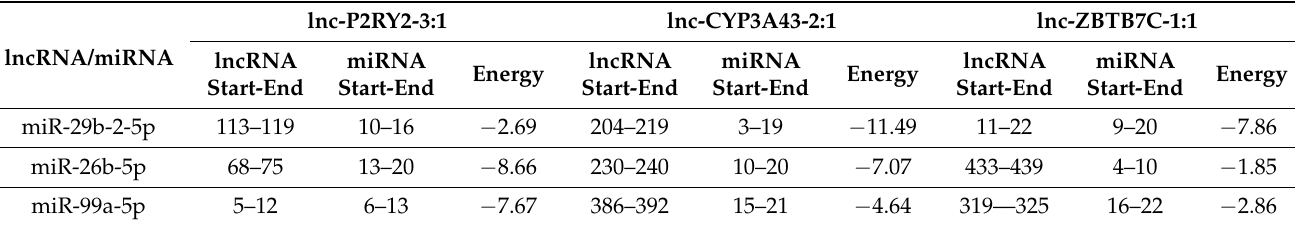
Table 1. Prediction of lncRNA-microRNA interaction.